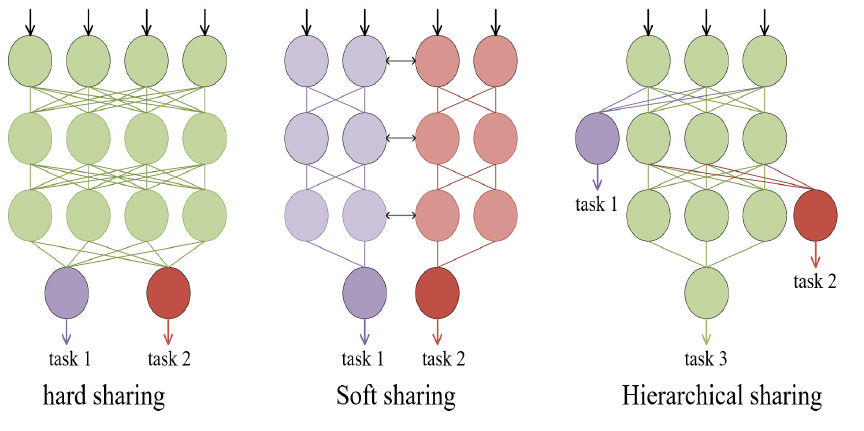
Figure 1. Parameter